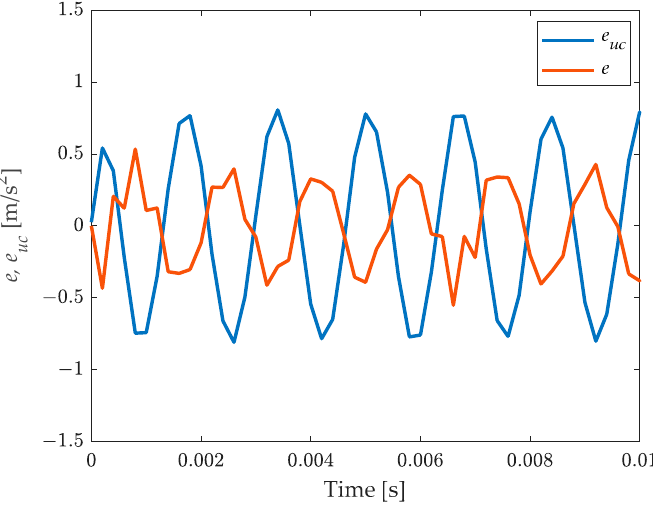
Figure 4. Comparison of the measurand with the final, compensated measurement result.